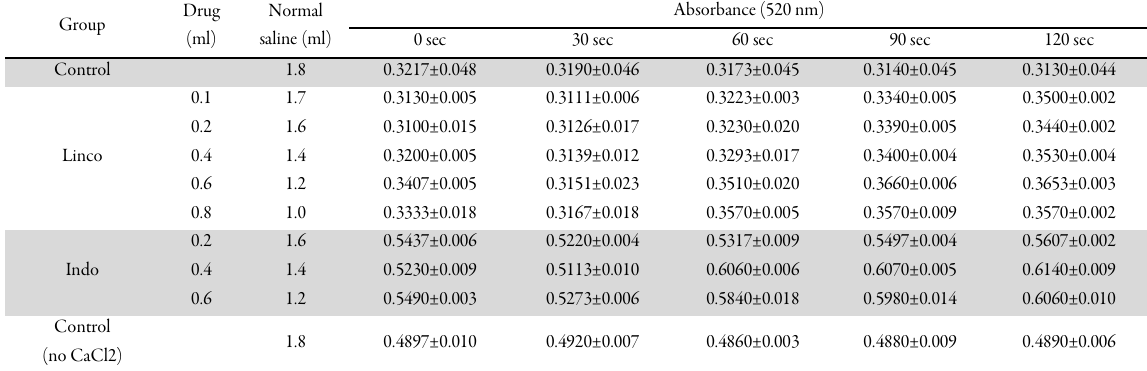
Table 7. Effect of Lincomycin on platelet aggregation